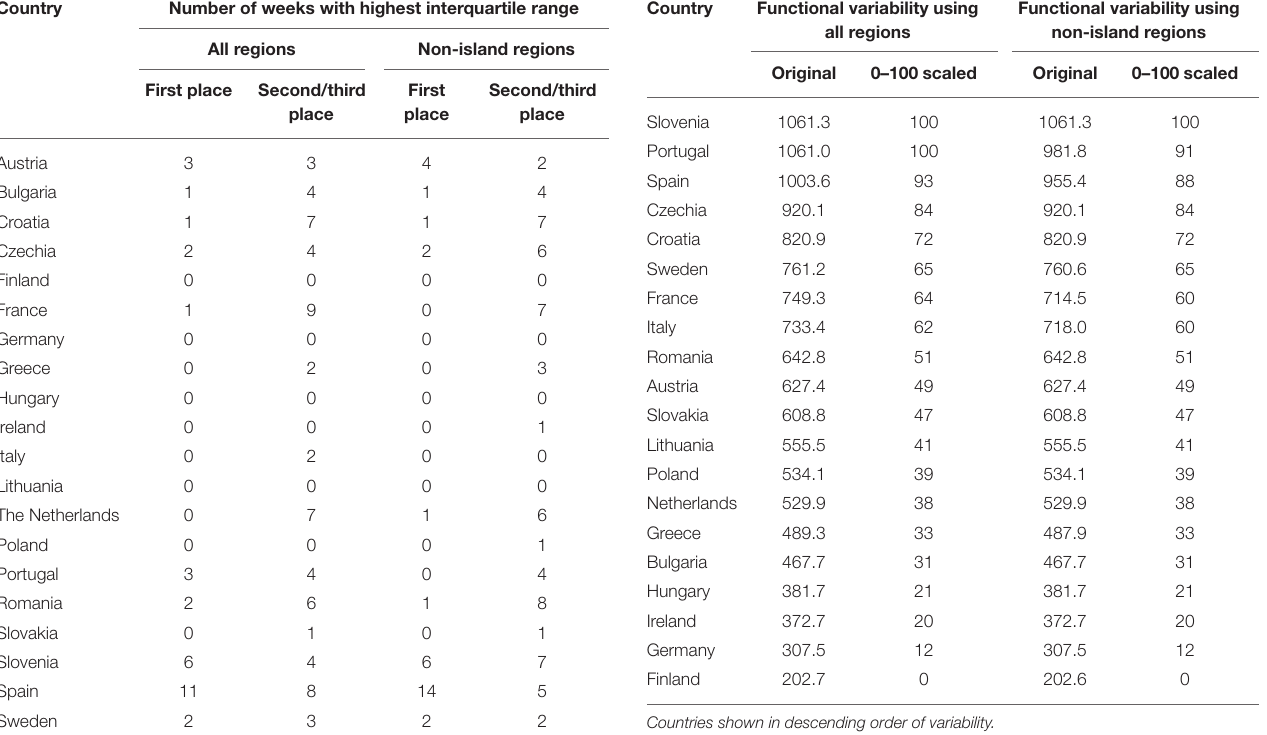
TABLE 2 | Number of weeks during which each country held first, or second-third place according to their interquartile range, in descending order of value. Country Number of weeks with highest interquartile range All regions